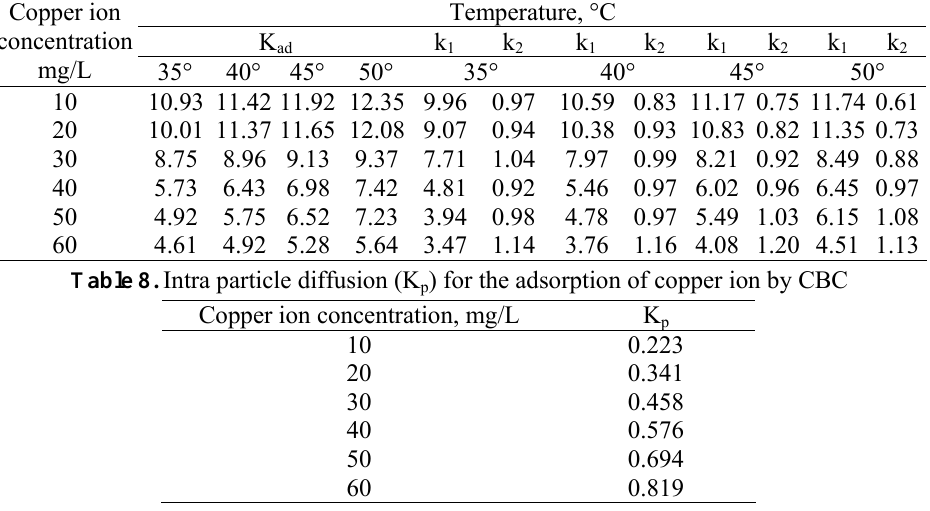
, min -1 ) process 2